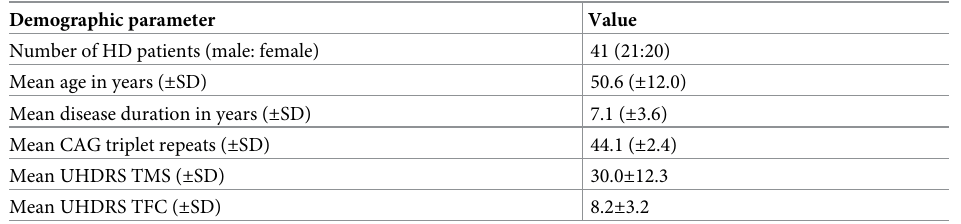
Table 1. Demographic data in the Huntington’s disease group.